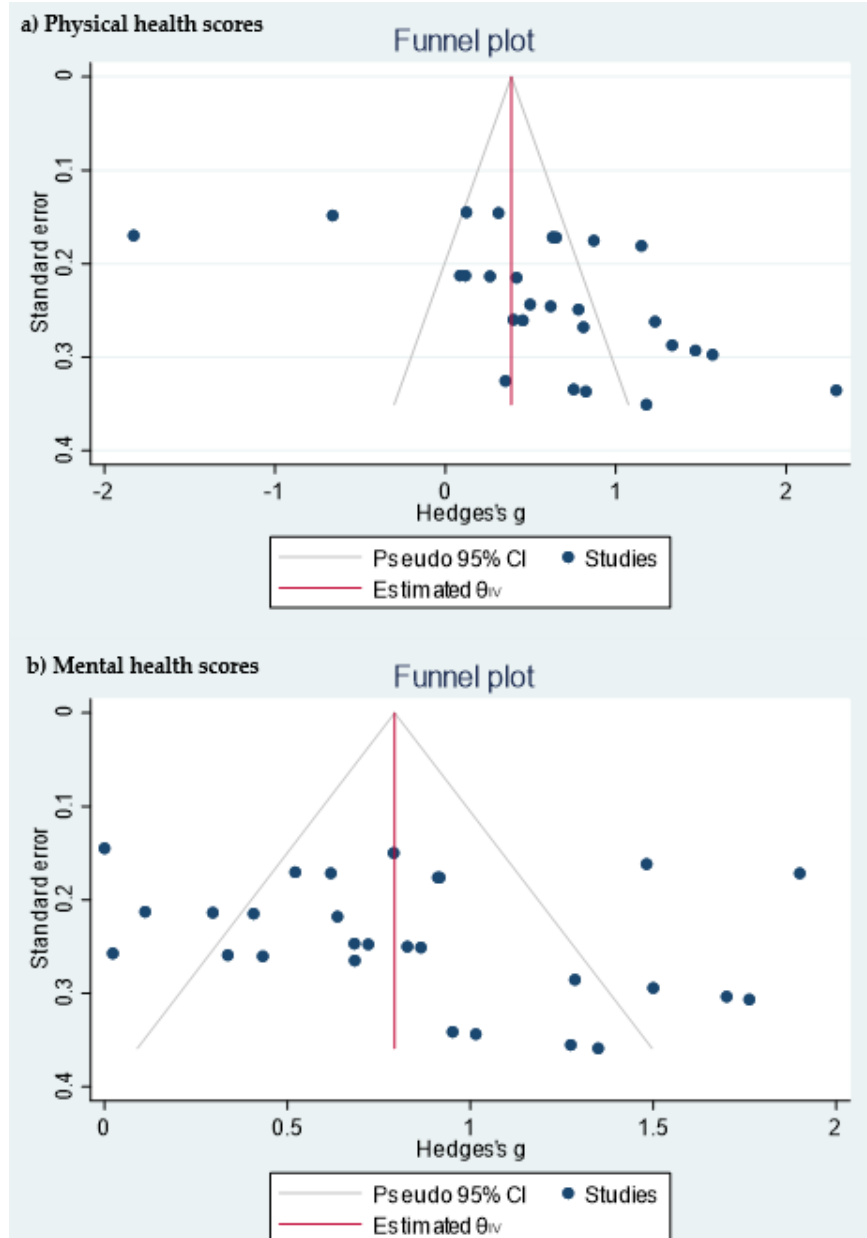
Figure 3. Funnel plot of the ( a ) physical health scores and ( b ) mental health scores.